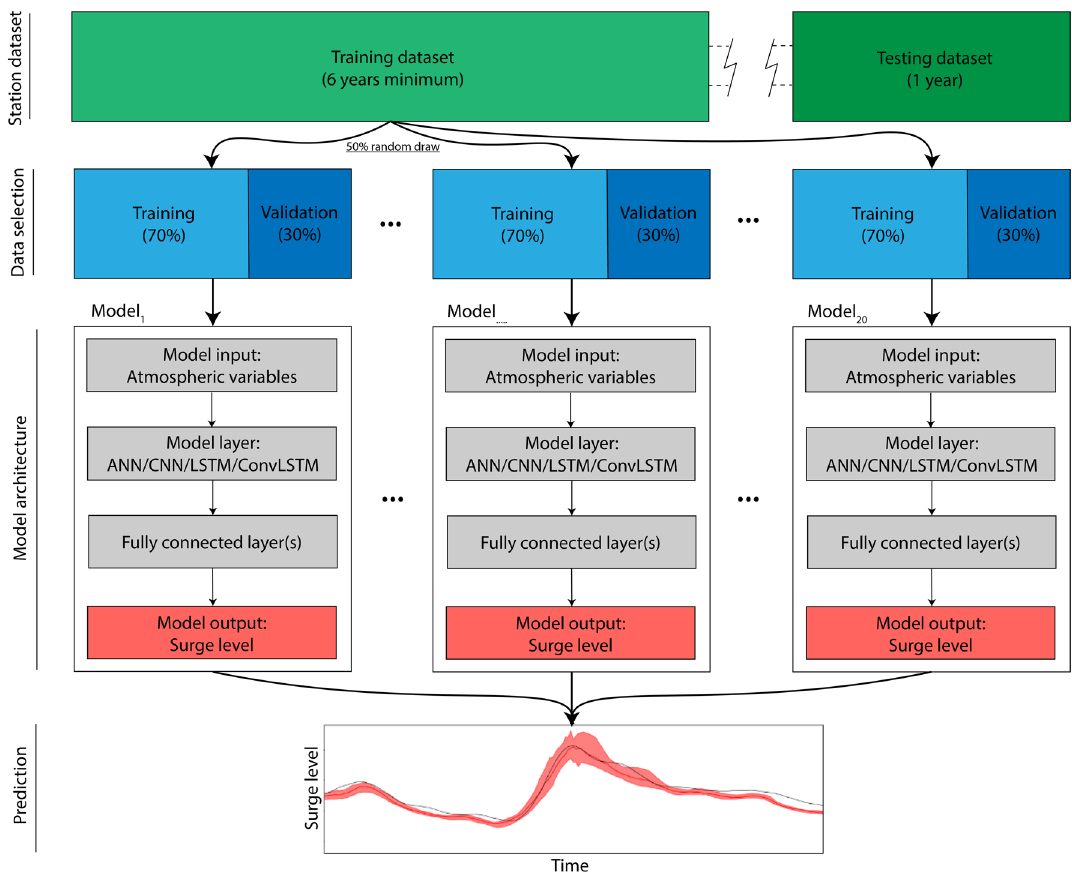
Figure 2. Overview of NN model ensemble and selection of